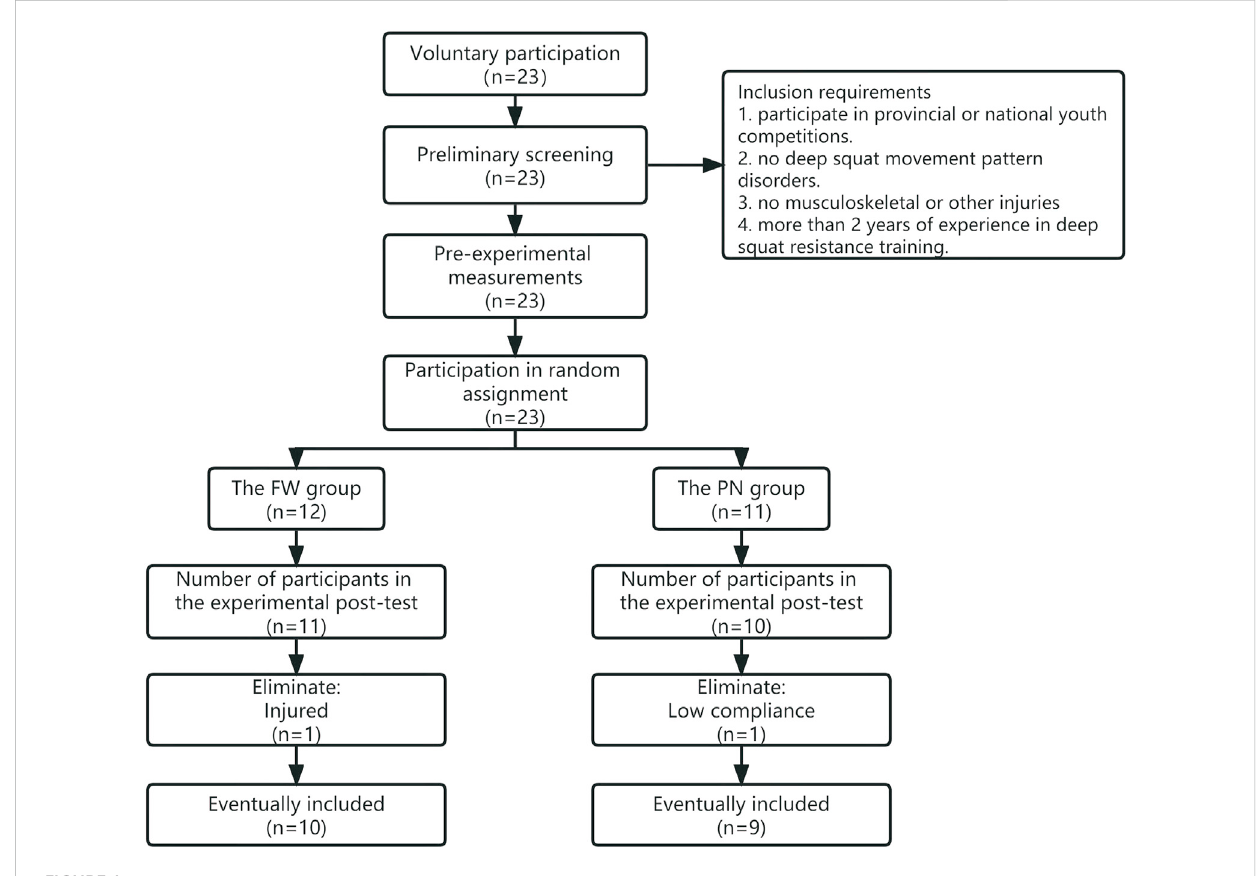
FIGURE 1 Population screening fl